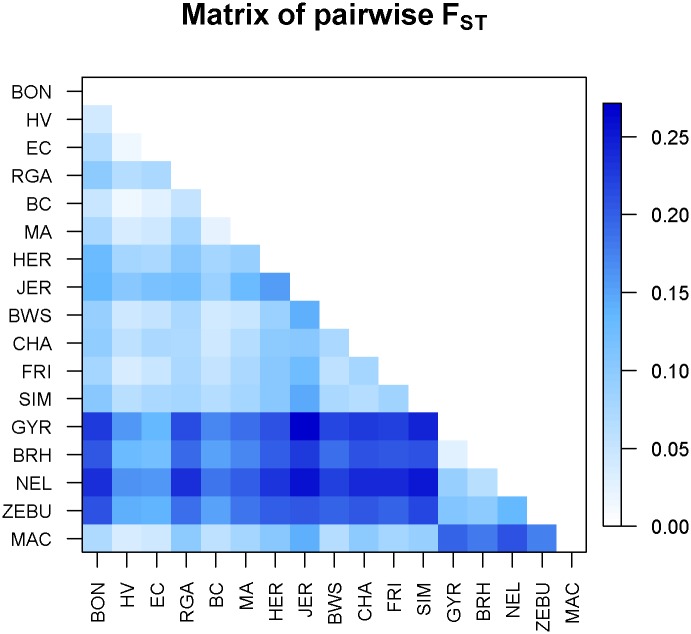
Pairwise FST distance matrix graphical representation.